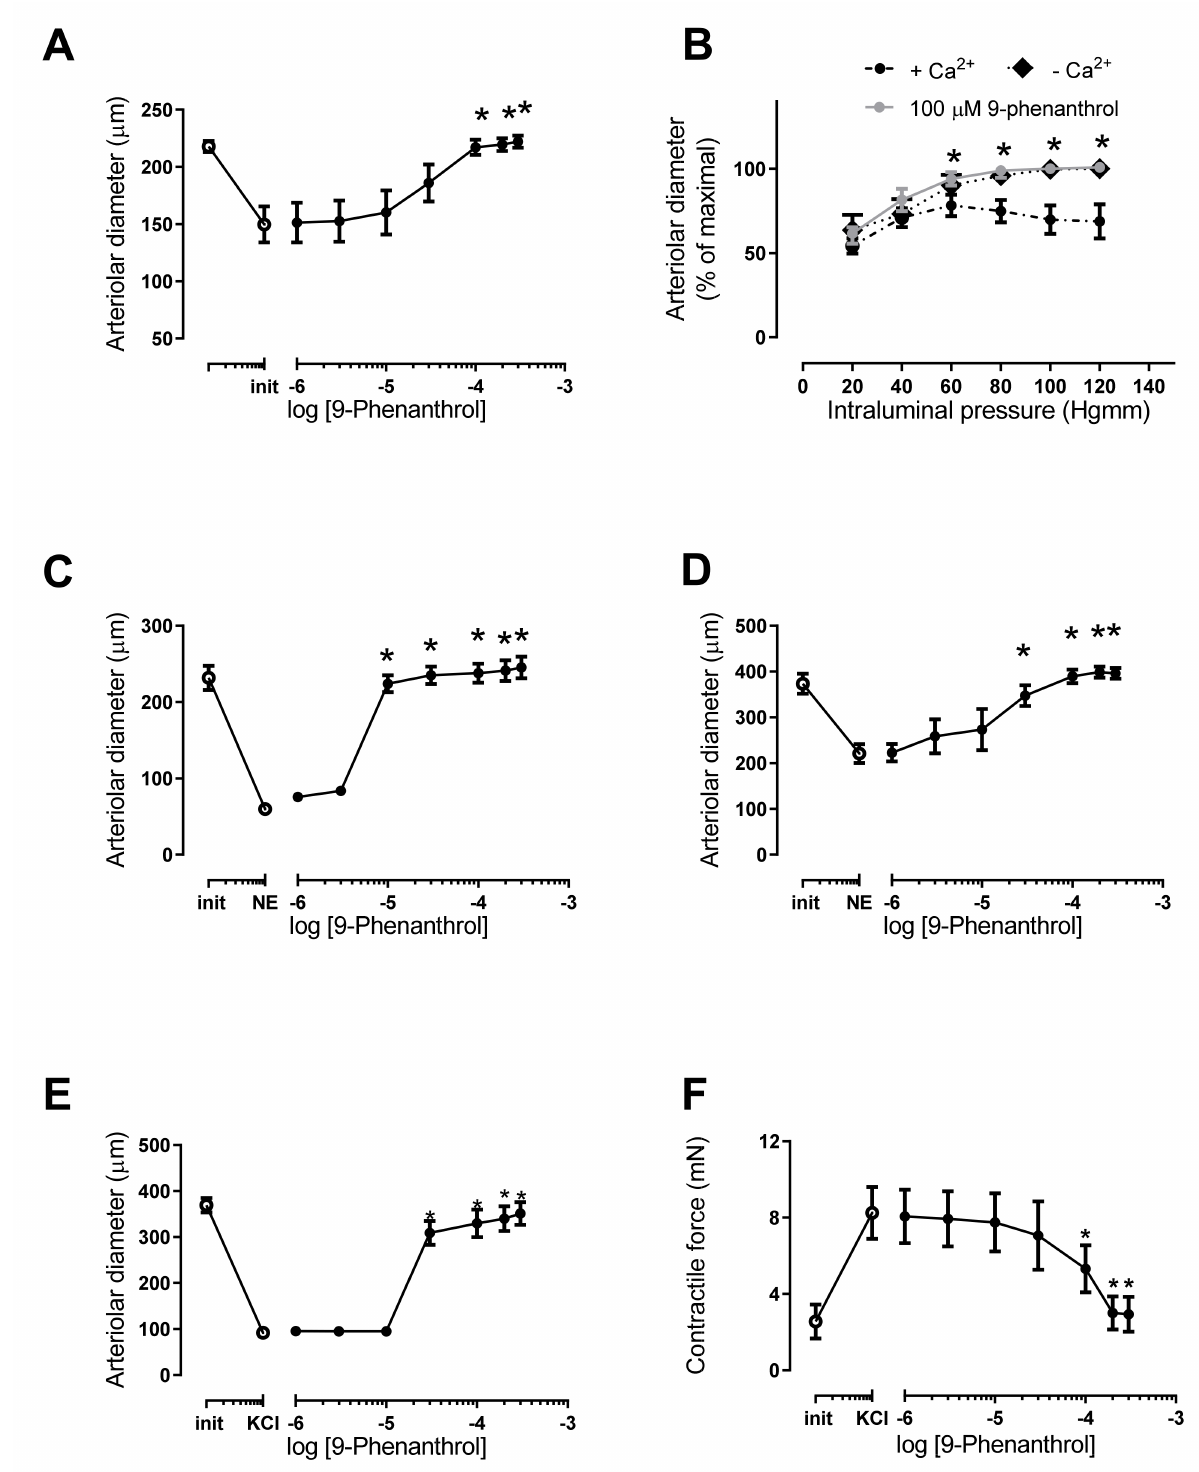
Figure 2. TRPM4 inhibitor 9-phenanthrol completely antagonized myogenic tone and both nore- pinephrine and KCl evoked vasoconstrictions. Pressure myography of rat skeletal muscle ( A – C ) and mesenteric ( D , E ) arteries was performed. Basilar arteries ( F ) were tested on an isometric force measurement system. ( A ) Myogenic tone was allowed to develop at 80 mmHg intraluminal pres- sure (first symbol: before, second symbol: after myogenic tone development), then